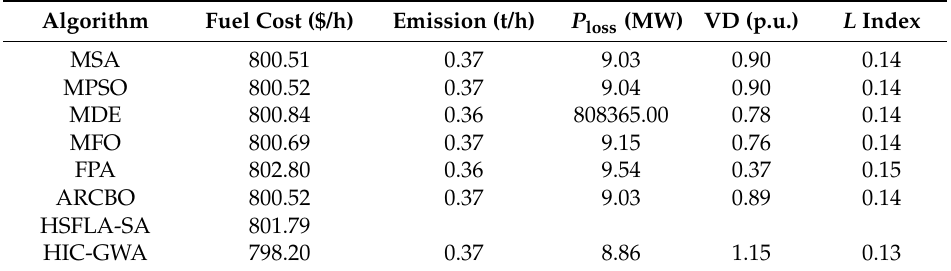
Table 5. Comparison of HIC-GWA with the literature for case study 1.